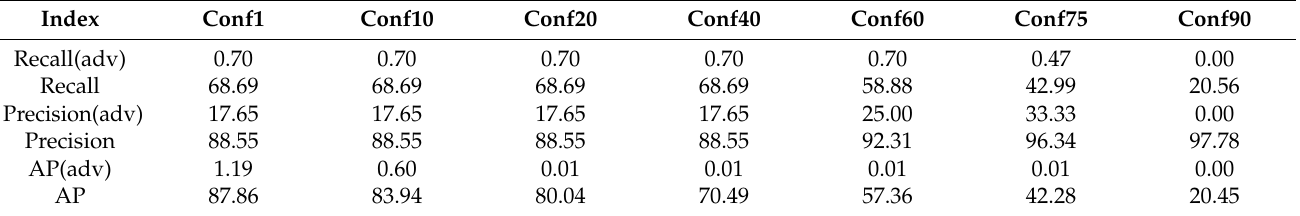
Table 4. The detection performance of YOLOv3 without defense and after defense when the adver- sarial patch is next to the detection